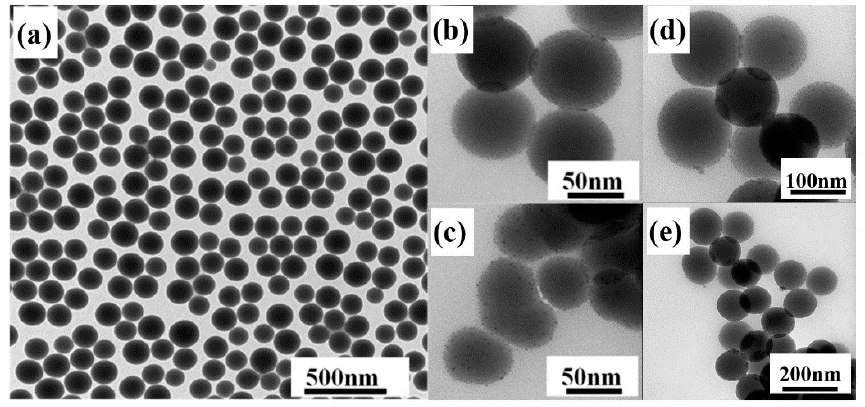
Figure 3. Transmission electron microscopy (TEM) image of ( a ) SiO 2 nanoparticles; ( b , d ) SiO 2 -Tm(TTA) 3 phen; ( c , e ) SiO 2 -Tm(DBM) 3 phen.